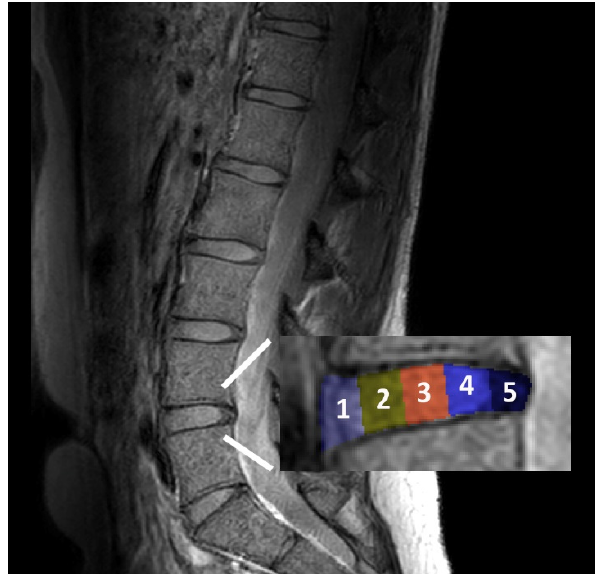
Figure 1. Graphical illustration of the segmentation of the IVD into five subregions from (1) anterior to (5) posterior aspect of the disc.